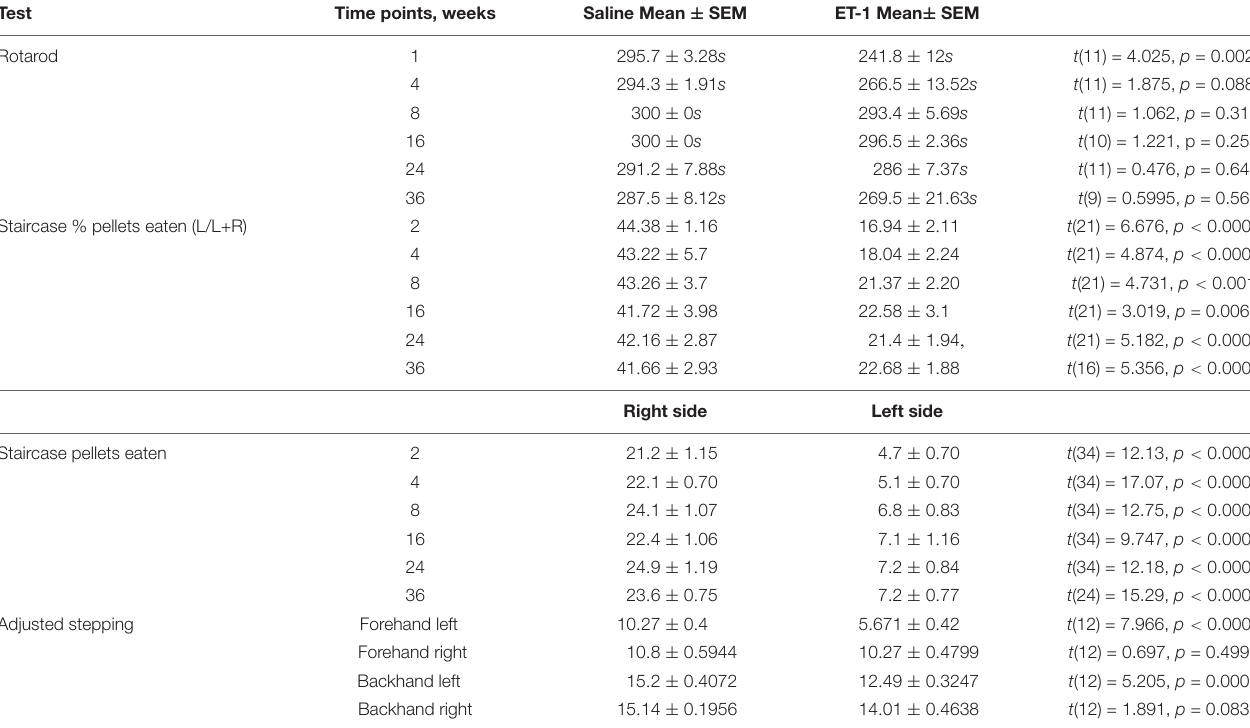
TABLE 1 | Statistical details for behavior